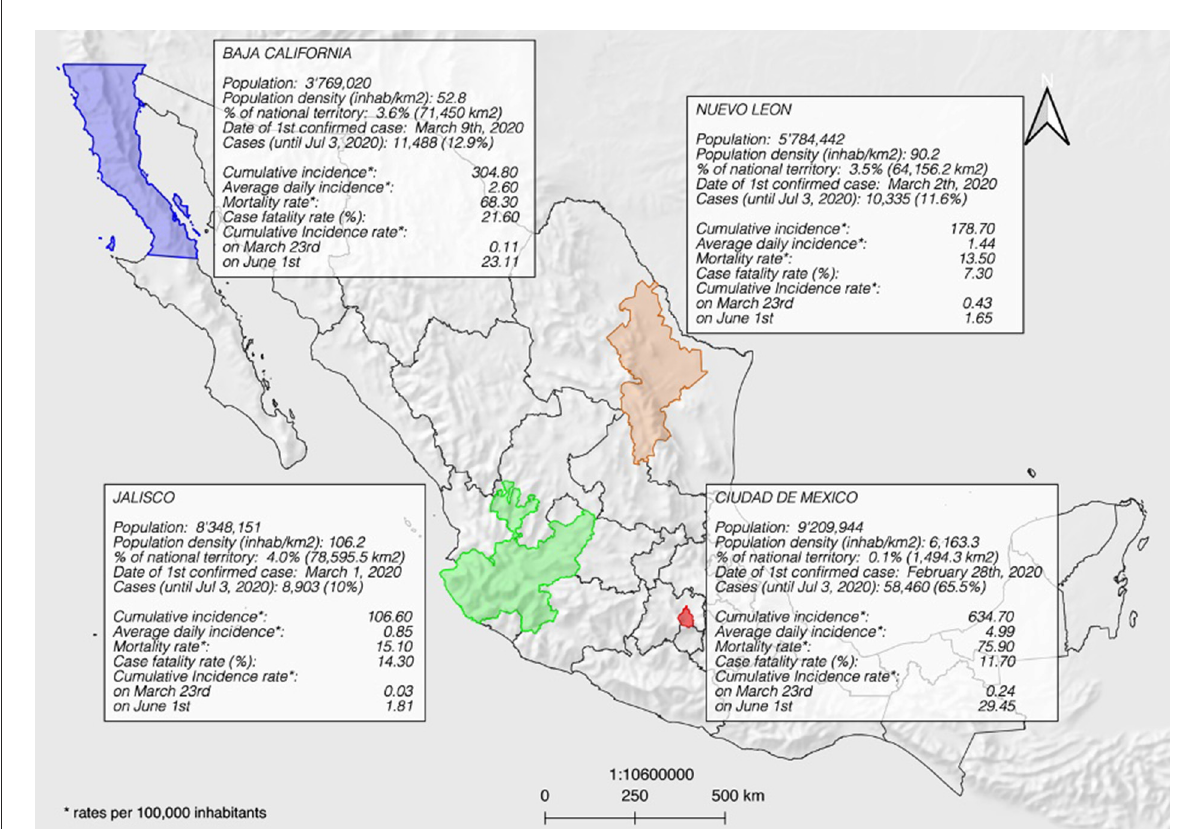
FIGURE1 The geographical location of the states studied and general characteristics of the COVID-19 pandemic, Mexico. The map shows the population of each state, its density per km 2 , the percentage it represents from the country’s territory, the date of the first confirmed cases, and confirmed cases until July 3, 2020. It also shows cumulative incidence, average daily incidence, the mortality rate per 100,000 habitants, case fatality rate, and the cumulative incidence rate on March 23rd, 2020 (beginning of the National Program of Safe Distance) and June 1st, 2020 (beginning of the New